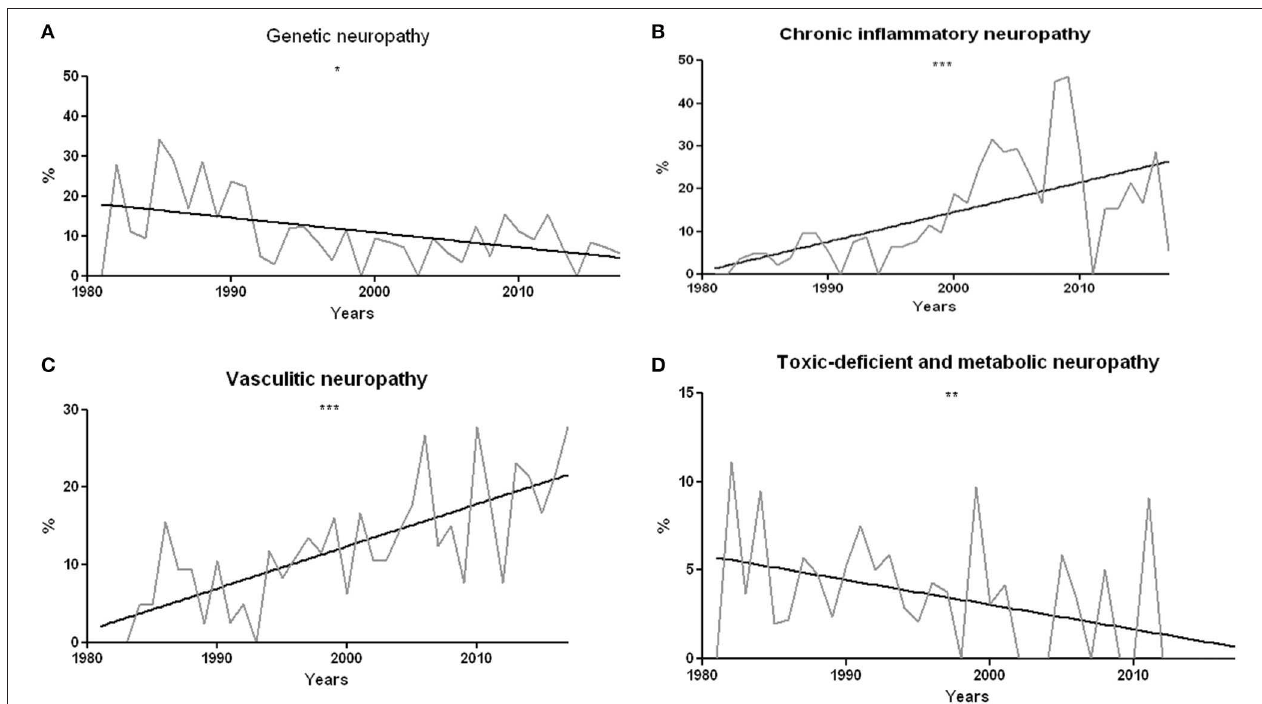
FIGURE 5 | (A) Percentage of genetic neuropathies compared to the total of univocal diagnostic indications over the years. The decrease is statistically significant, with r 2 = 0.26 and p = 0.016. (B) Percentage of chronic inflammatory neuropathies compared to the total of unique diagnostic indications over the years. The percentage increase is statistically significant, with r 2 = 0.38 and p < 0.0001. (C) Percentage of vasculitic neuropathies compared to the total of unique diagnostic indications year by year. The percentage increase is statistically significant, with r 2 = 0.60 and p < 0.0001. (D) Percentage of toxic-deficient and metabolic neuropathies compared to the total of univocal diagnostic indications year by year. The percentage decrease is statistically significant, with r 2 = 0.22 and p = 0.004. * p < 0.05, ** p < 0.01, and *** p < 0.001.